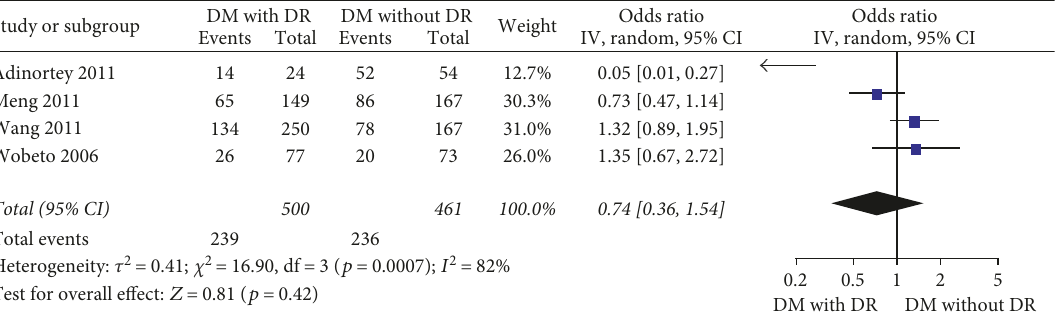
Study or subgroup